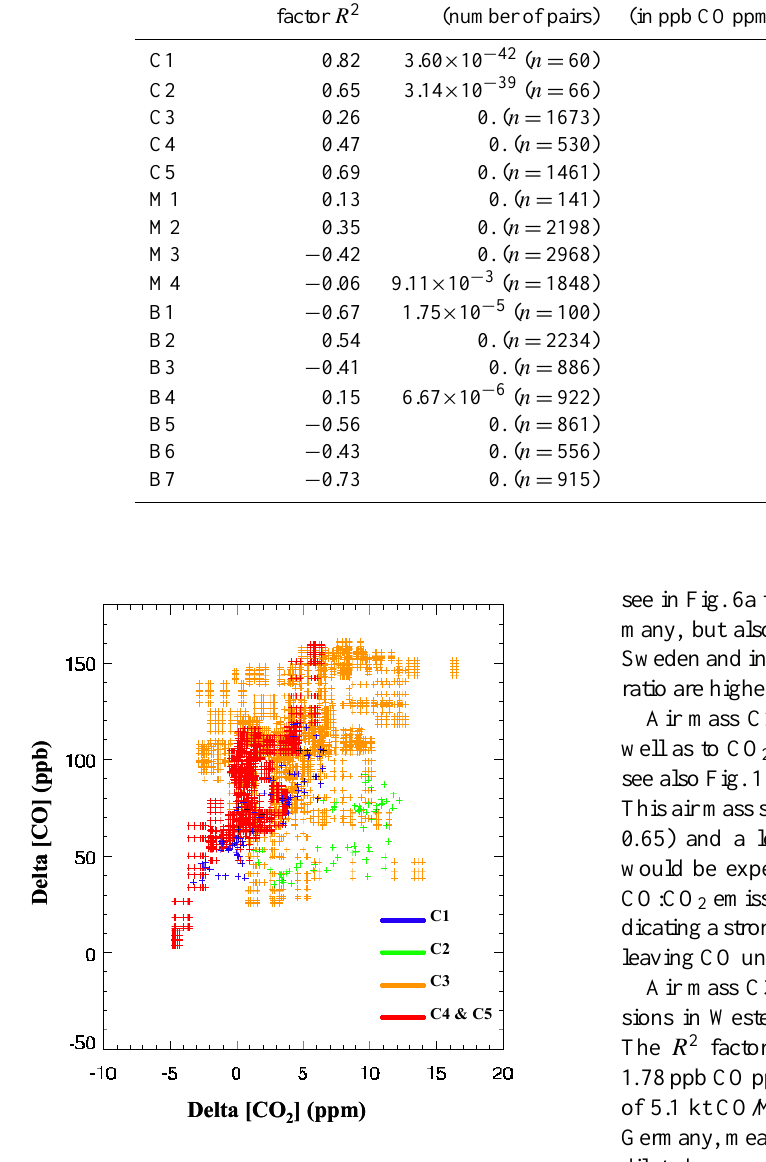
Fig. 8. 1 CO (i.e. CO minus CO marine background concentration) versus 1 CO 2 (i.e. CO 2 minus CO 2 marine background concentra- tion) for the CAATER 2 flights. Colors represent correlated events C1 to C5 as defined in the text. See Sect. 3 for marine background concentration definition.